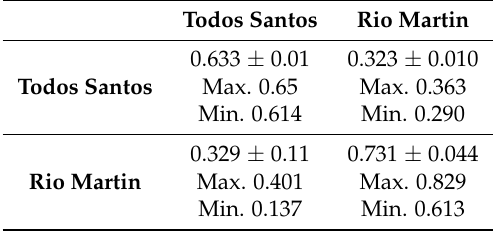
Table 4. Confusion matrix showing the measured (correlation) performance | r x , y | when applying the Todos Santos synthesized indices to the Rio Martin watershed, and vice